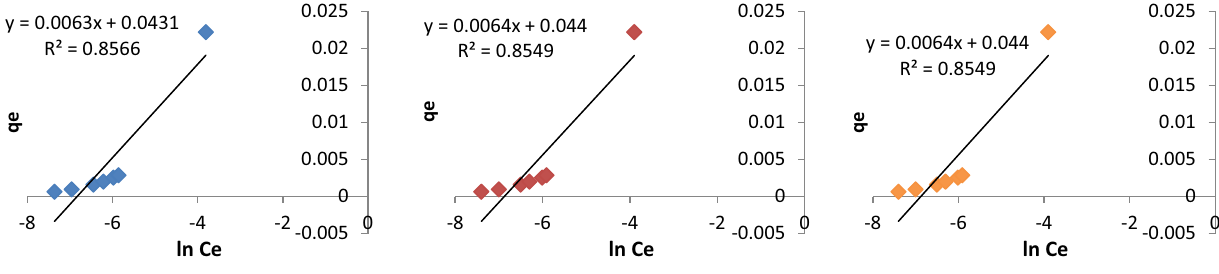
Fig. 6 Temkin isotherms for the removal of Cu(II) using GNSCP, SSCP and CCP Table 2 Adsorption isotherm characteristics for the removal of Cu(II) using the chosen three adsorbents